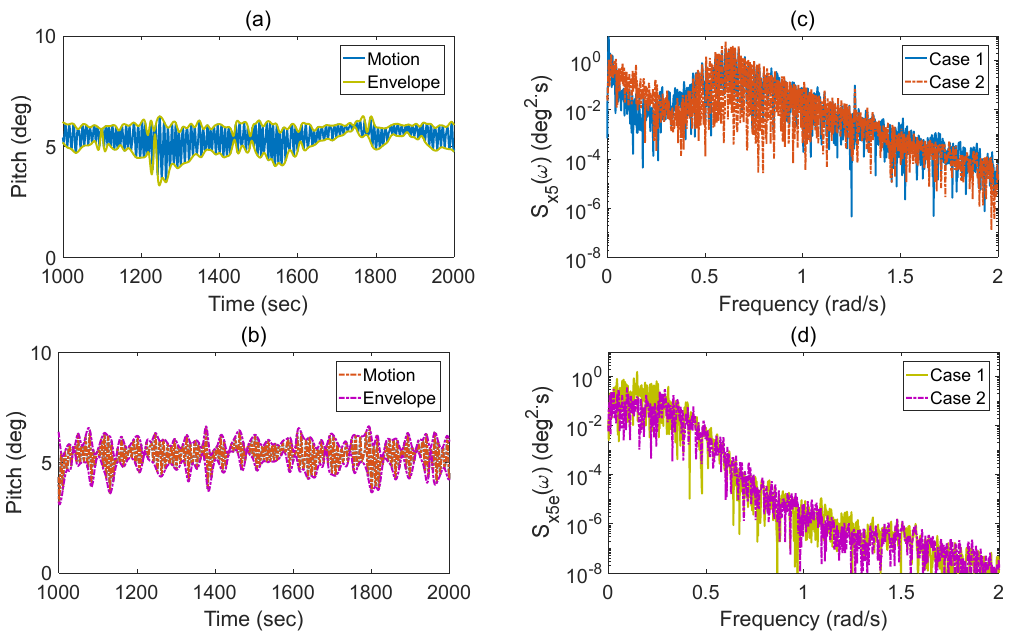
Figure 9. Time histories and power density spectra of pitch motion. ( a ) Time histories under the wave group; ( b ) Time histories under the stochastic wave; ( c ) The power density spectra of pitch motion; ( d ) The power density spectra of pitch motion envelope.